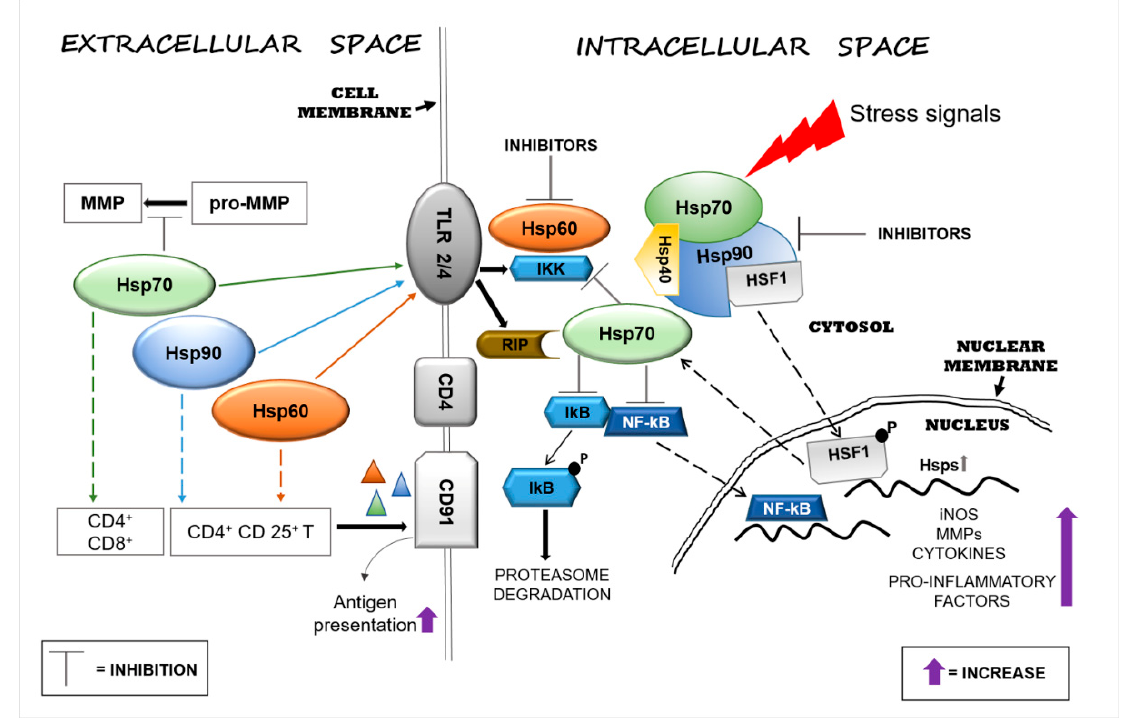
Figure 1. Heat shock protein (Hsp)60, Hsp70, and Hsp90 modulate inflammatory reactions by interacting with factors involved in the regulation of innate and adaptive immune responses. Stressors can activate the immune system and, in turn, promote neurodegeneration by inducing Hsps in brain tissue as a mechanism of protection. Extracellular Hsp60, Hsp70, and Hsp90 interact with receptors present on the surface of cells of the neural tissue’s immune compartment (e.g., microglia) and elicit pro- or anti-inflammatory responses, depending on the local cellular status. The interaction of extracellular Hsp60, Hsp70, and Hsp90 with toll-like receptor (TLR)2/4 induces the activation of the nuclear factor-kappa B (NF-kB) inhibitor protein, which in turn triggers the activation of the NF-kB pathway, promoting an inflammatory response. Hsp60, Hsp70, and Hsp90 form complexes with antigens (represented by triangles) mediating their presentation via the CD91 cell surface receptor on antigen-presenting cells (APCs) [28]. Hsp90 plays a proinflammatory role through the interaction with its client proteins, such as members of the receptor-interacting protein (RIP) kinases and, thereby, activates the NF-kB pathway. Under physiological conditions, intracellular Hsp90, by blocking heat shock factor (HSF)1, prevents the transcription of Hsp genes, such as Hsp70, or other genes that code for anti-inflammatory molecules. The pharmacological inhibition of Hsp90 can lead to upregulation of the transcription of intracellular Hsp70 and of anti-inflammatory molecules by its release. Abbreviations: MMP, matrix metalloproteinase; TLR, toll-like receptor; IKK, inhibitor of κ B kinase; RIP, receptor interaction protein; CD, cluster of differentiation; lkB, inhibitory subunit I kappa B-alpha; NF-kB, nuclear factor kappa-light-chain-enhancer of activated B cells; HSF1, heat shock factor 1; P, phosphate; Hsp, heat shock protein; iNOS, inducible isoform of nitric oxide synthase.